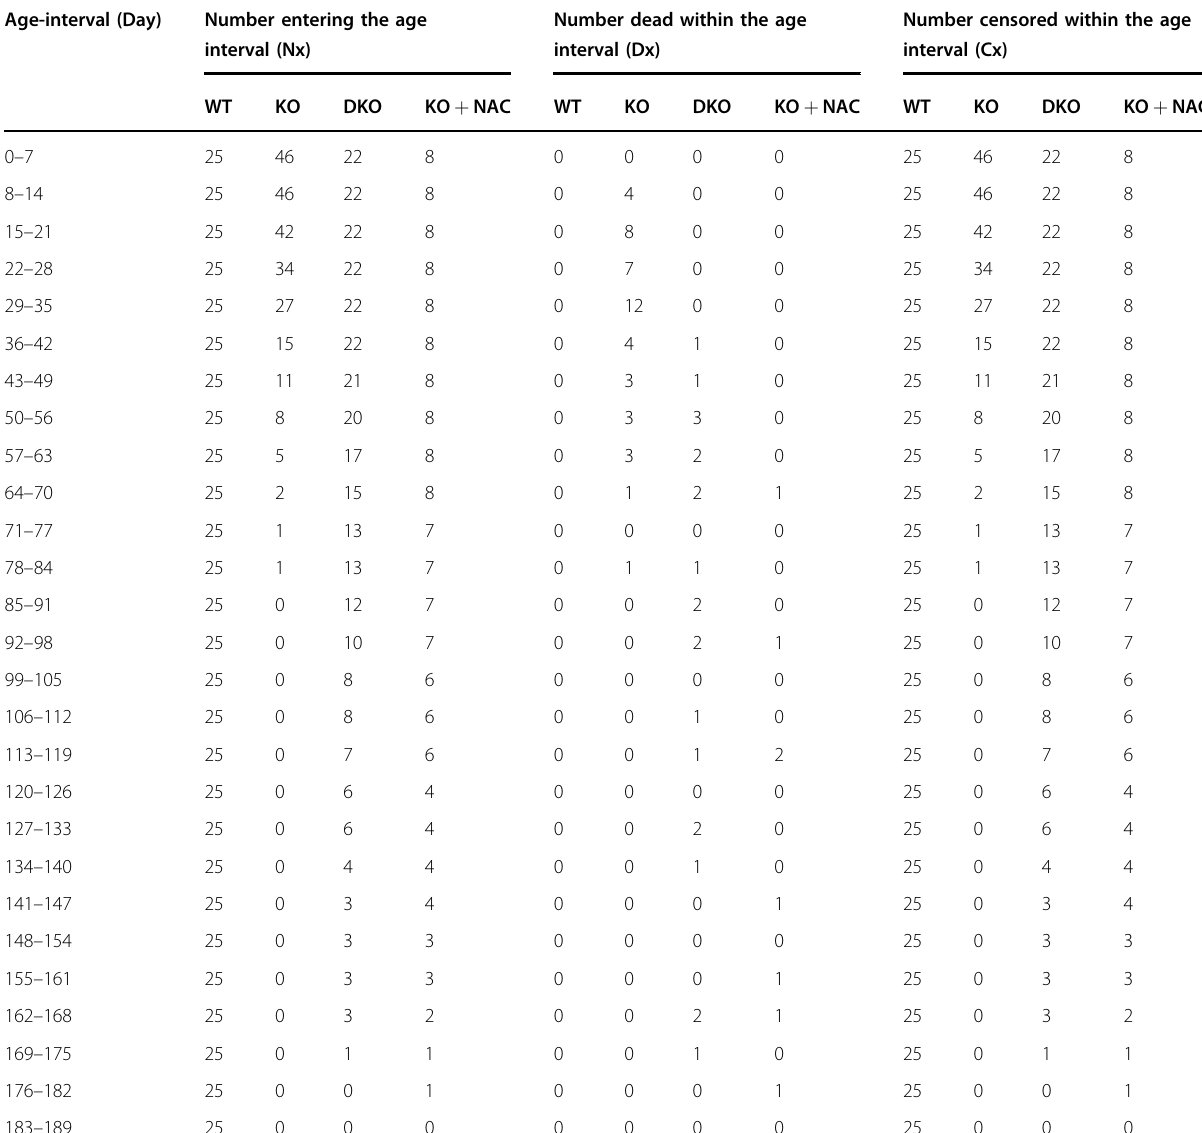
Table 2 Lifetime survival